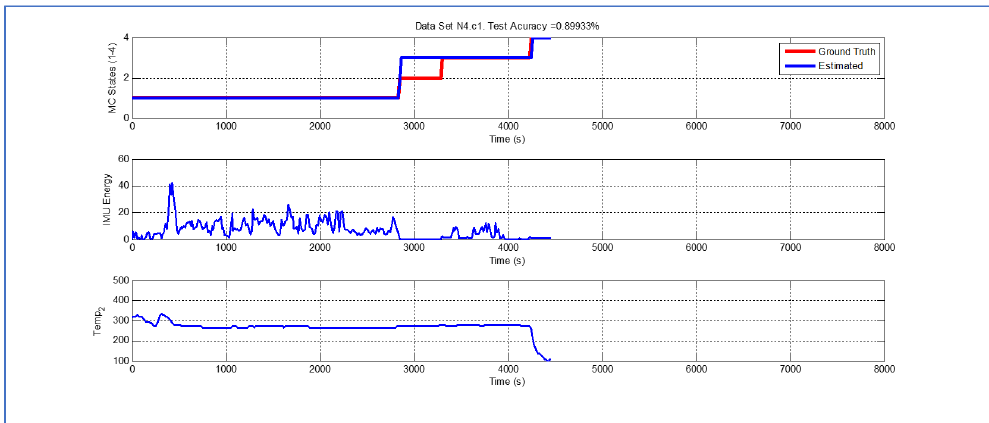
Figure 12. Detection of berry harvesting stages. Dataset N 4 c 1 .